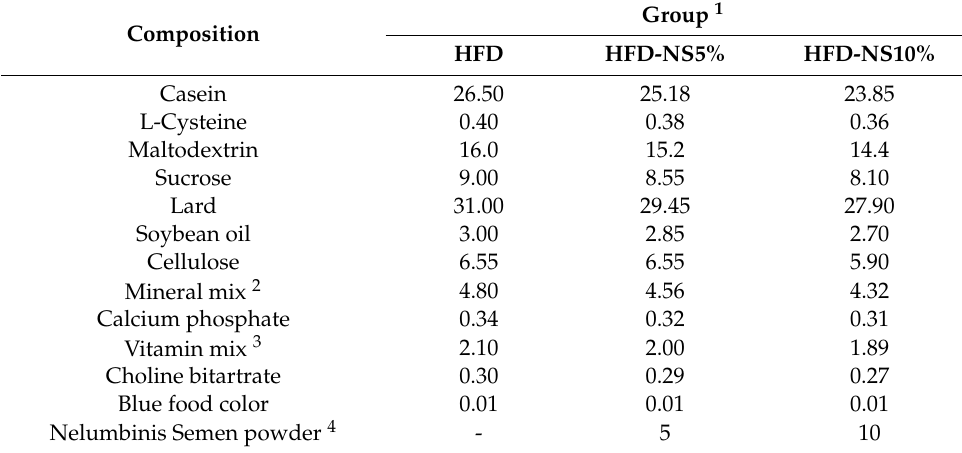
Table 1. Composition (% by weight) of the HFD